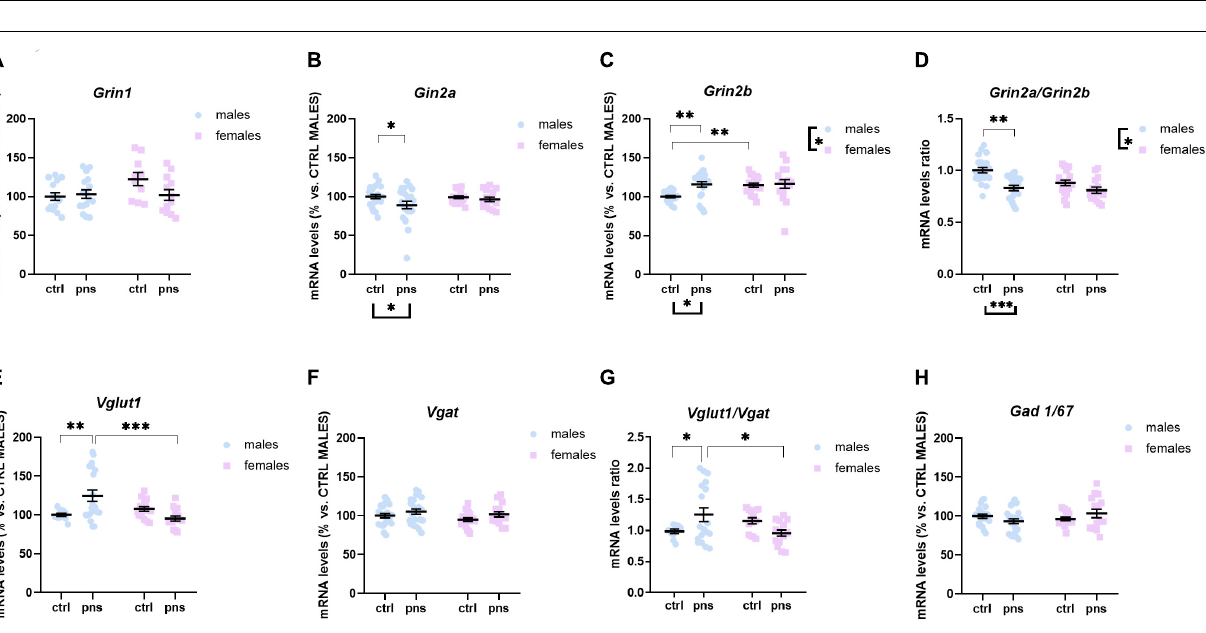
FIGURE 3 | Analysis of ( A ) Grin1 , ( B ) Grin2a , and ( C ) Grin2b mRNA levels; ( D ) Grin2a:Grin2b ratio; ( E ) Vglut1 and ( F ) Vgat mRNA levels; ( G ) Vglut1/vgat ratio; and ( H ) Gad 1/67 mRNA levels in the prefrontal cortex of male and female rats exposed to prenatal stress. Data are expressed as a percentage of control males not exposed to stress (set at 100%) and represent the mean ± SEM of at least 10 independent determinations. Data information: symbols represent individual data. ∗ p < 0.05; ∗∗ p < 0.01; ∗∗∗ p < 0.001 vs. control males (two-way ANOVA with Bonferroni’s multiple-comparison